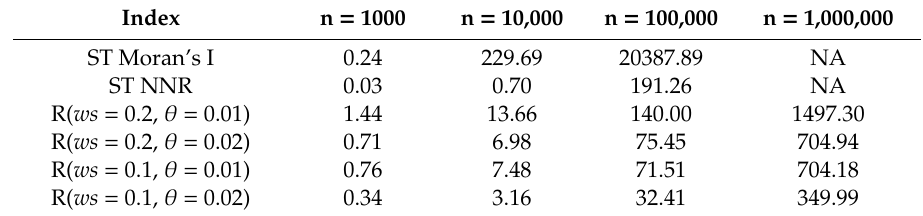
Table 4. The computation time (seconds) of di ff erent sample size for three ST models, where NA represents the computation process is not finished within 10 h (36,000 s).